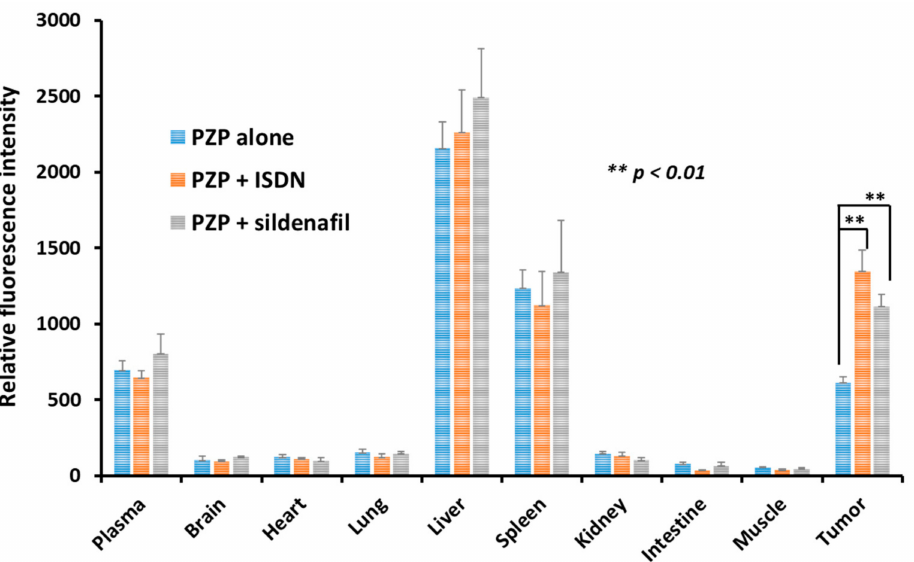
Figure 1. Enhancement of delivery of PZP to tumors by using EPR-effect enhancers. Male, 6-week-old, BALB/c mice bearing Colon 26 tumor were given 10 mg/kg PZP iv; ISDN at 30 mg/kg intraperi- toneally or sildenafil citrate at 30 mg/kg subcutaneously immediately after PZP. The amount of drug in each tissue was quantified by using fluorescence spectroscopy, with the excitation wavelength of 422 nm (corresponding to ZnPP). Data are expressed as means ± SD. See text for